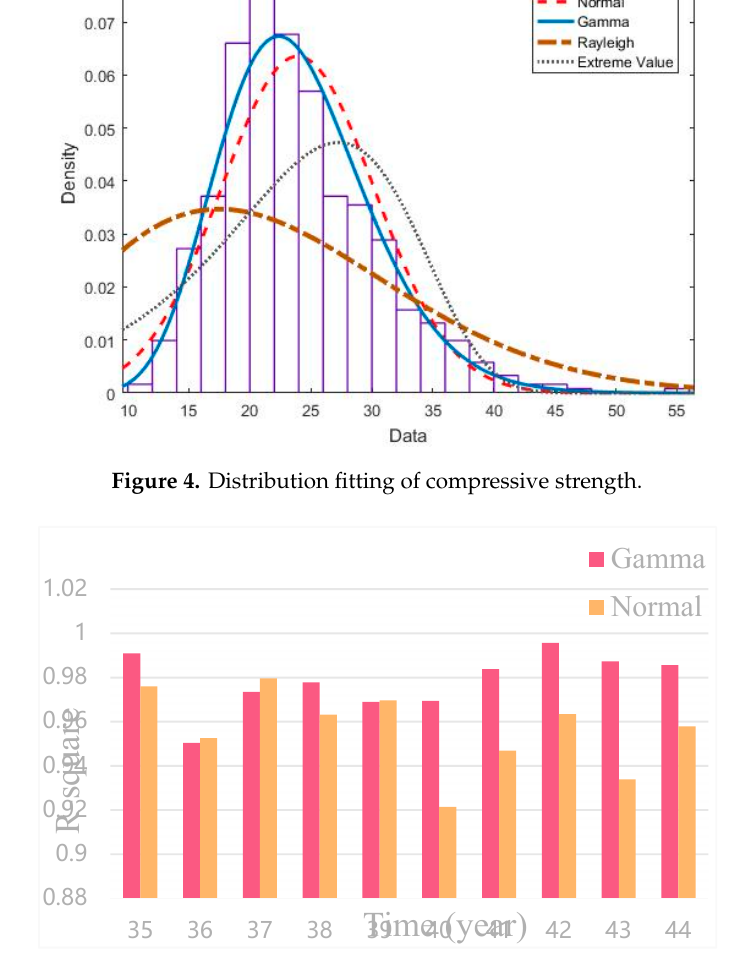
Figure 5. Contrast of goodness of fit for gamma distribution and normal distribution.